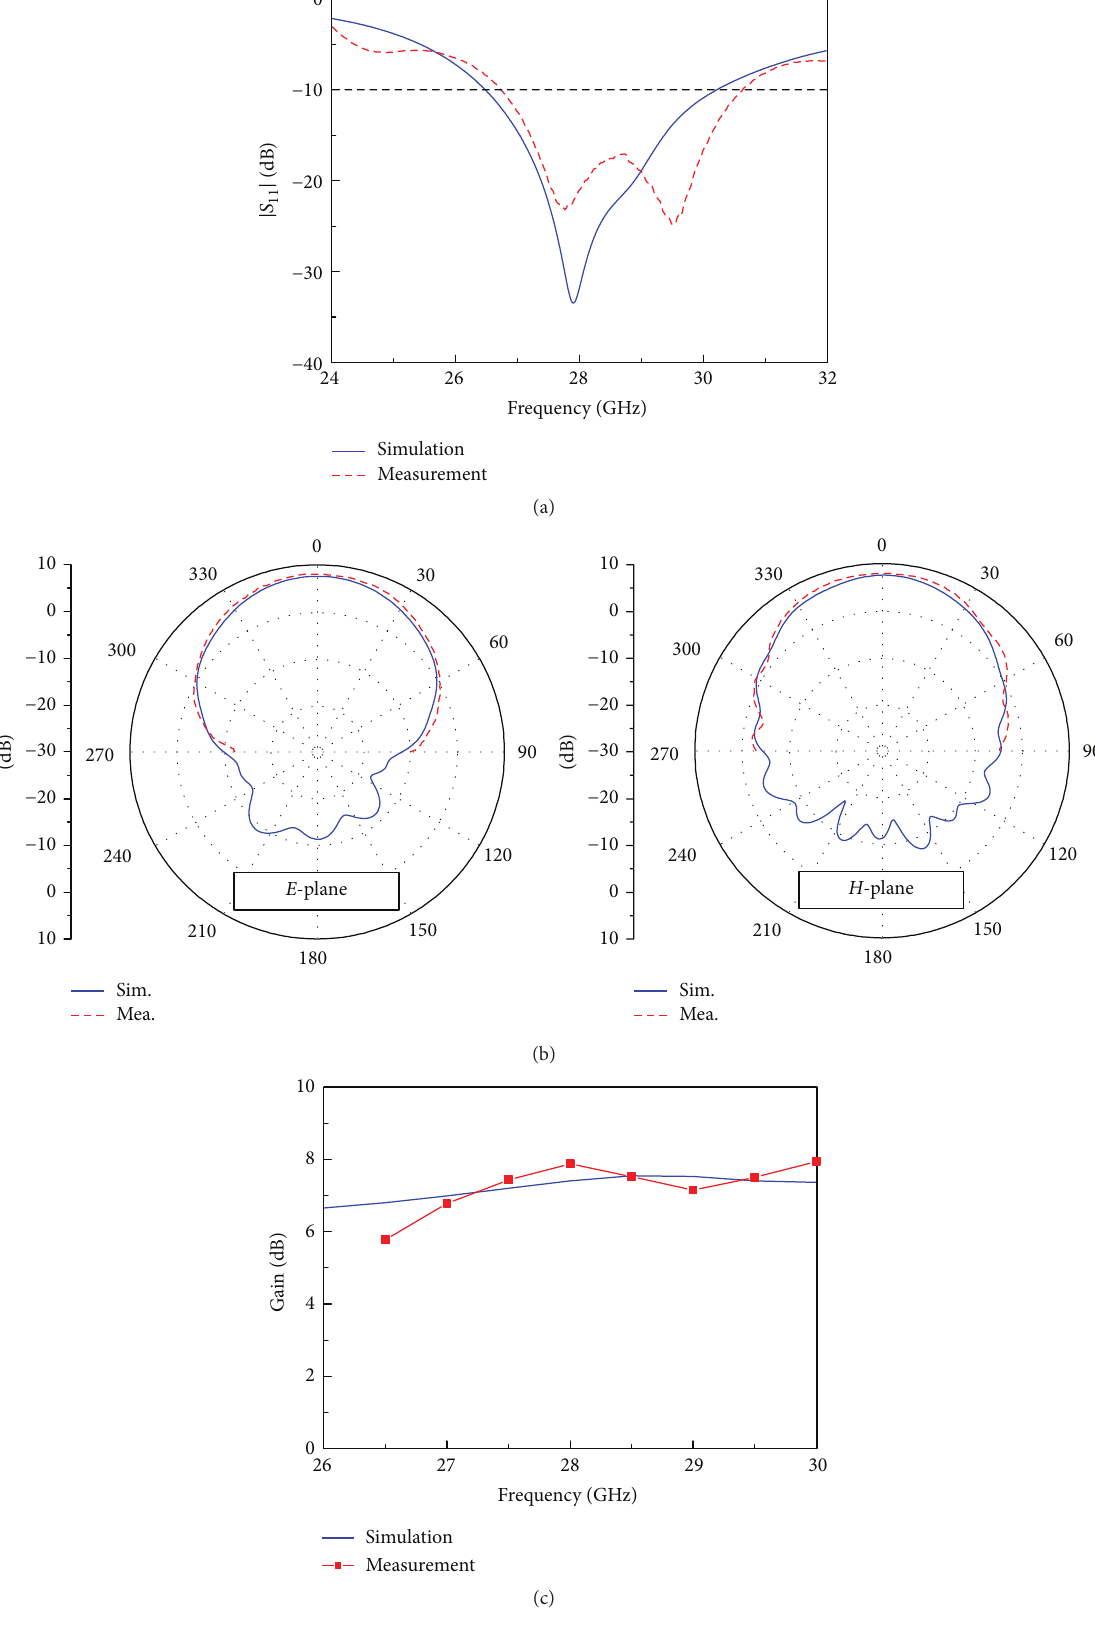
Figure 4: Measured and simulated (a) |𝑆 11 | , (b) 28 GHz gain pattern, and (c) broadside gain